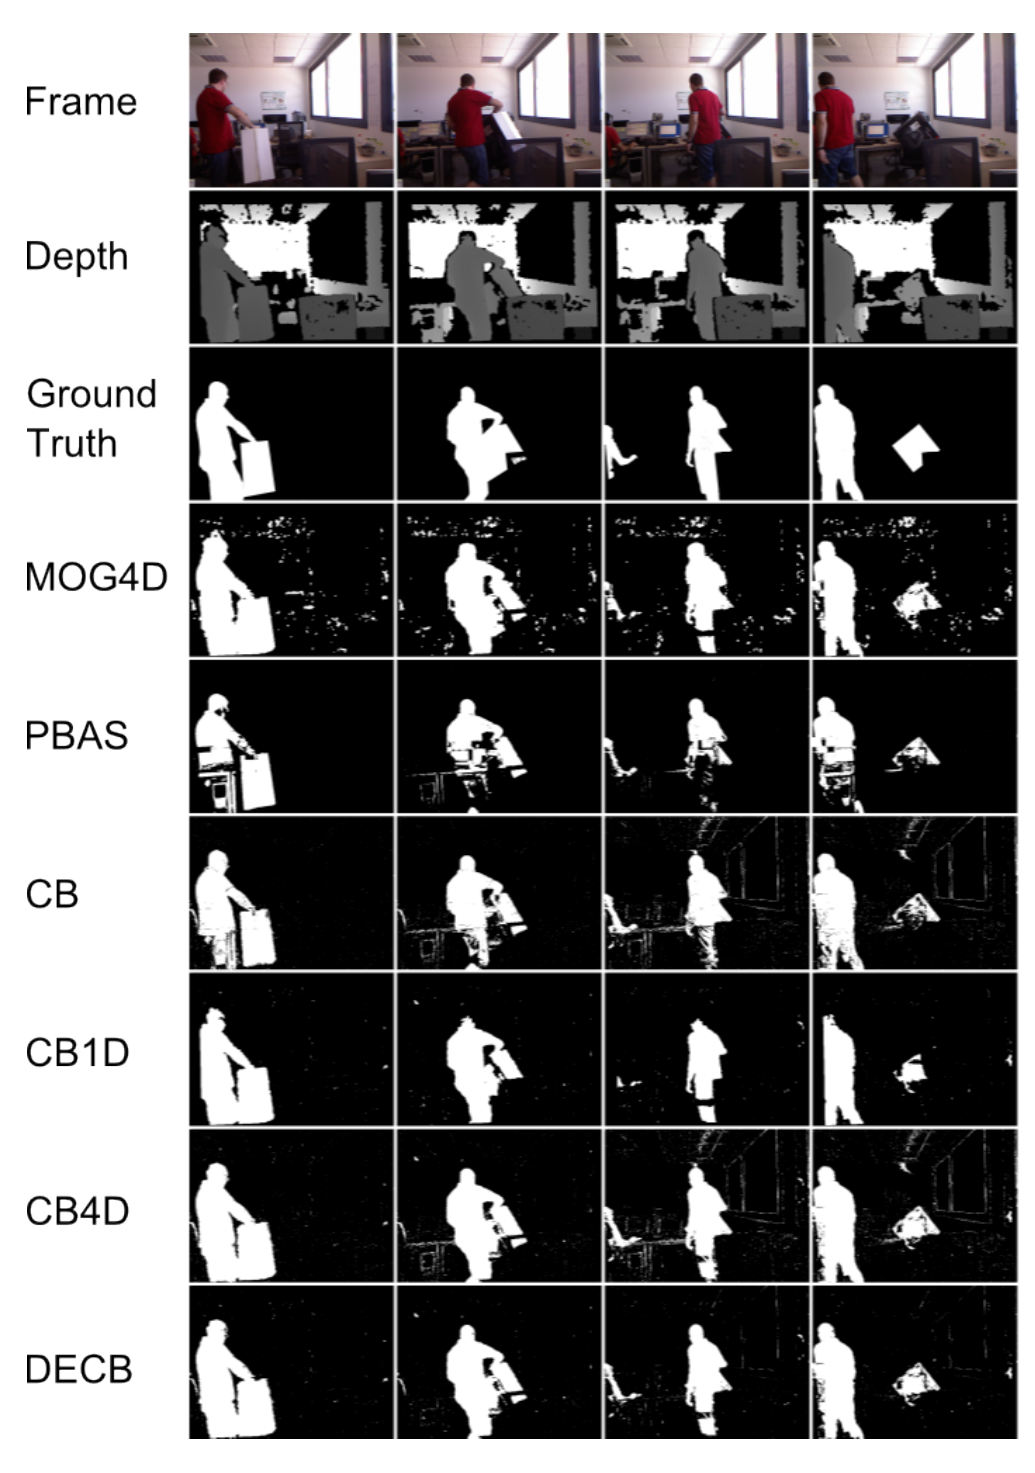
Figure 3. Results obtained from the test, ChairBox. 4D version of Mixture of Gaussians (MOG4D) includes a morphological opening stage, whilst Codebook-based approaches do not perform it, producing, then, more noise, due to isolated pixels. Most of this noise is filtered by the Depth-Extended Codebook (DECB) by means of the fusion